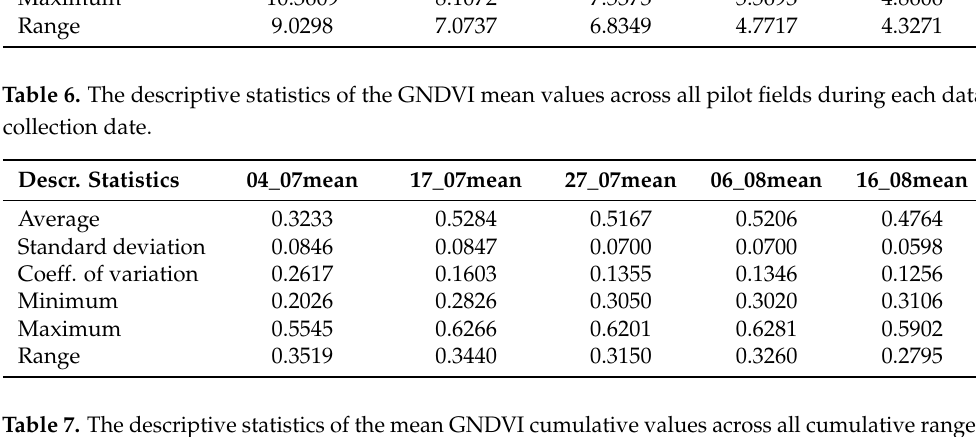
Table 7. The descriptive statistics of the mean GNDVI cumulative values across all cumulative ranges and pilot fields.